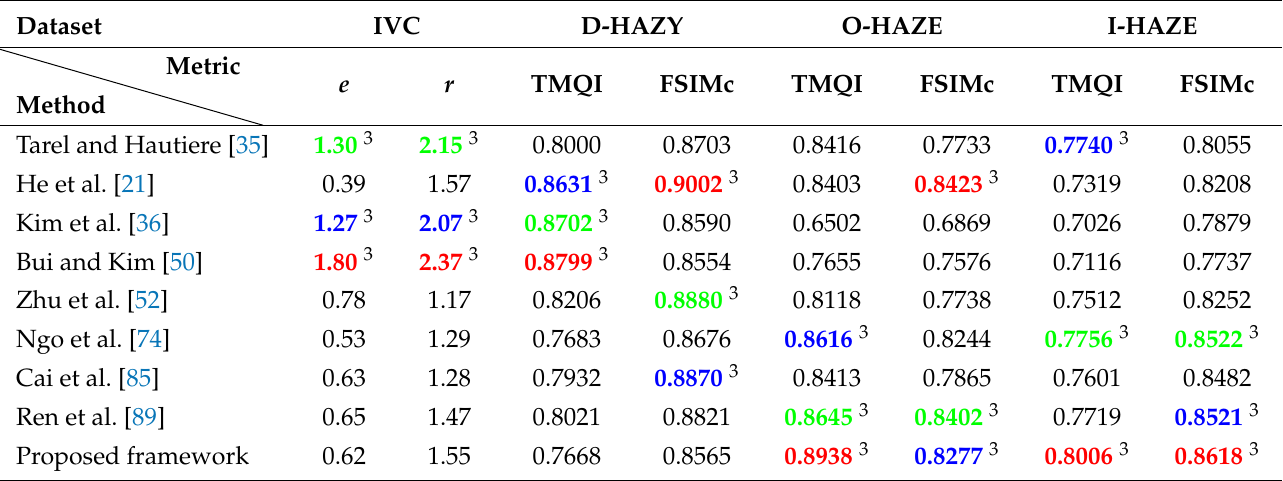
Table 6. Quantitative evaluation results of different dehazing methods on the IVC, D-HAZY, O-HAZE, and I-HAZE datasets.